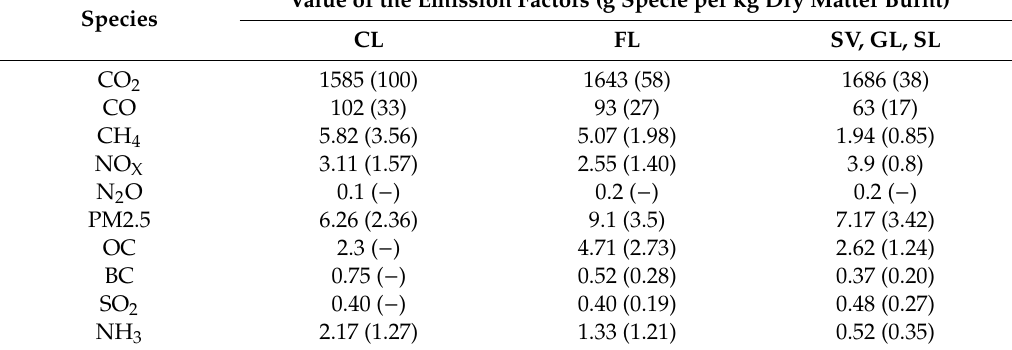
Table 1. Value of the emission factors in each of the trace gases and aerosols (standard error in